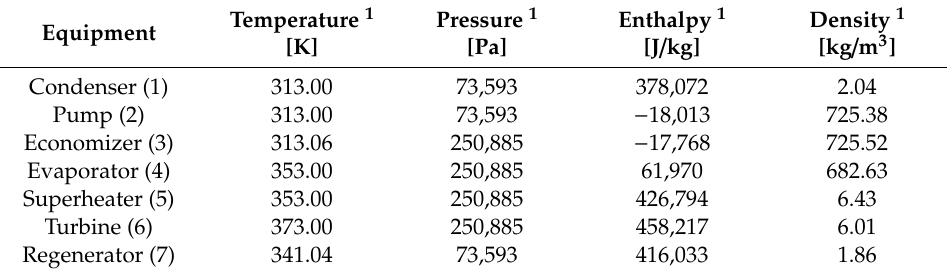
Table 1. Cyclopentane thermodynamic parameters.